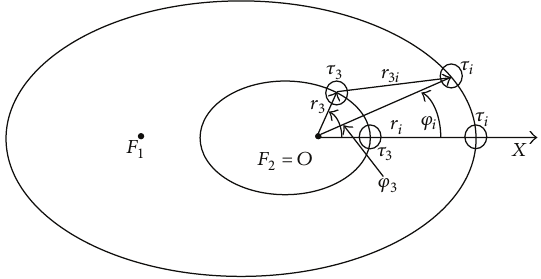
Figure 4: The geometric sketch of circulation of the outer planet 𝜏 𝑖 (Mars or Jupiter, Saturn, Uranus, Neptune, and Pluto) and the Earth 𝑂 of the 𝜏 3 around the mass center